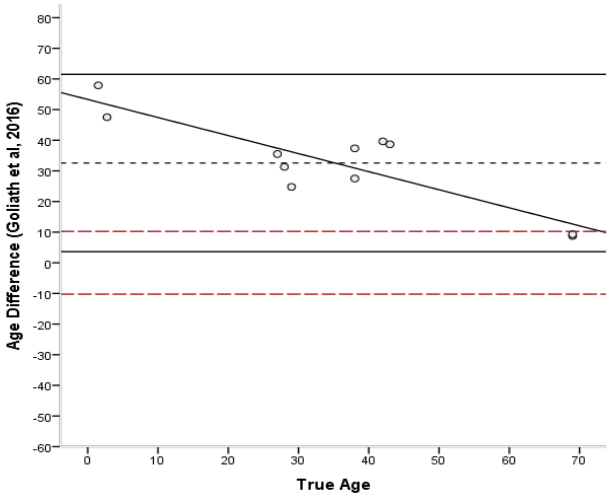
Figure 5. Bland–Altman plot for Goliath’s et al. [16] method illustrating the differences between known and estimated ages for the ribs against the known age. Depicted are 95% limits of agreement (black horizontal lines), mean difference/bias (black dotted line), best fit lines and 95% confidence intervals of the SEE for each method (dashed lines). R 2 of the best fit line: 0.758.